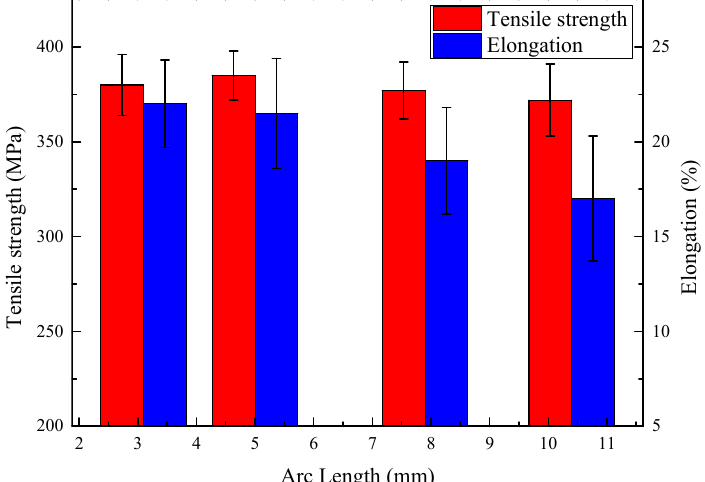
Figure 14. The tensile strengths and elongations of the welded joints with different arc lengths in the projected transfer zone.